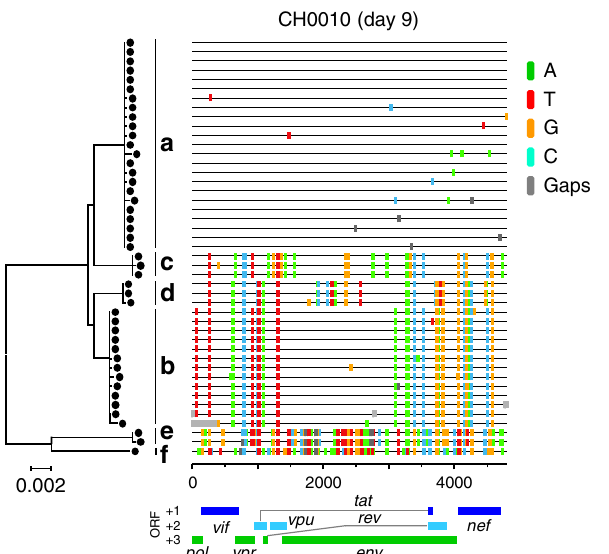
Fig. 1 Highlighter plot and phylogenetic tree of 3 ′ half genome sequences at screening time for CH0010. Six distinct T/F viruses (labeled a – f) were identi fi ed. Each line represents a 3 ′ half genome sequence, and mutations from the major T/F ( fi rst sequence at the top) are color coded according